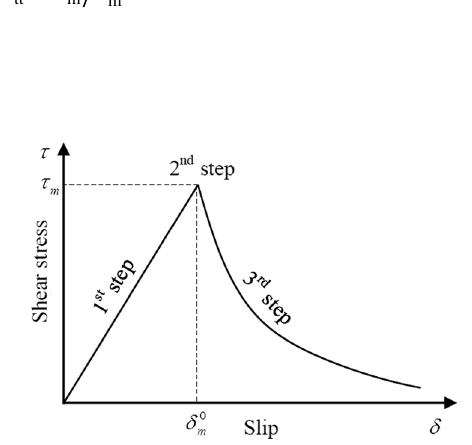
Fig. 9 Damage law for the cohesive behavior (Rezazadeh et al.